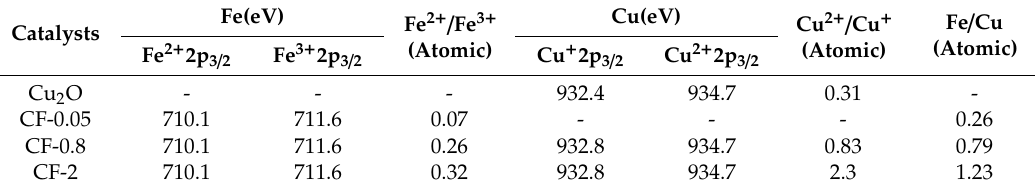
Figure 5. XPS spectra of Cu 2 O and Cu x O-Fe y O z . Table 2. Peak position and peak area ratio of different elements and valence states.